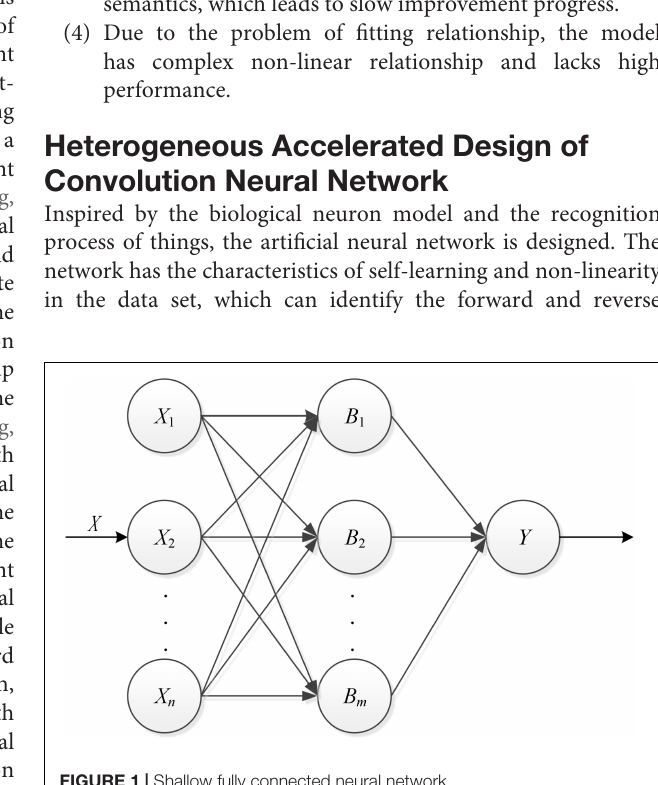
FIGURE 1 | Shallow fully connected neural